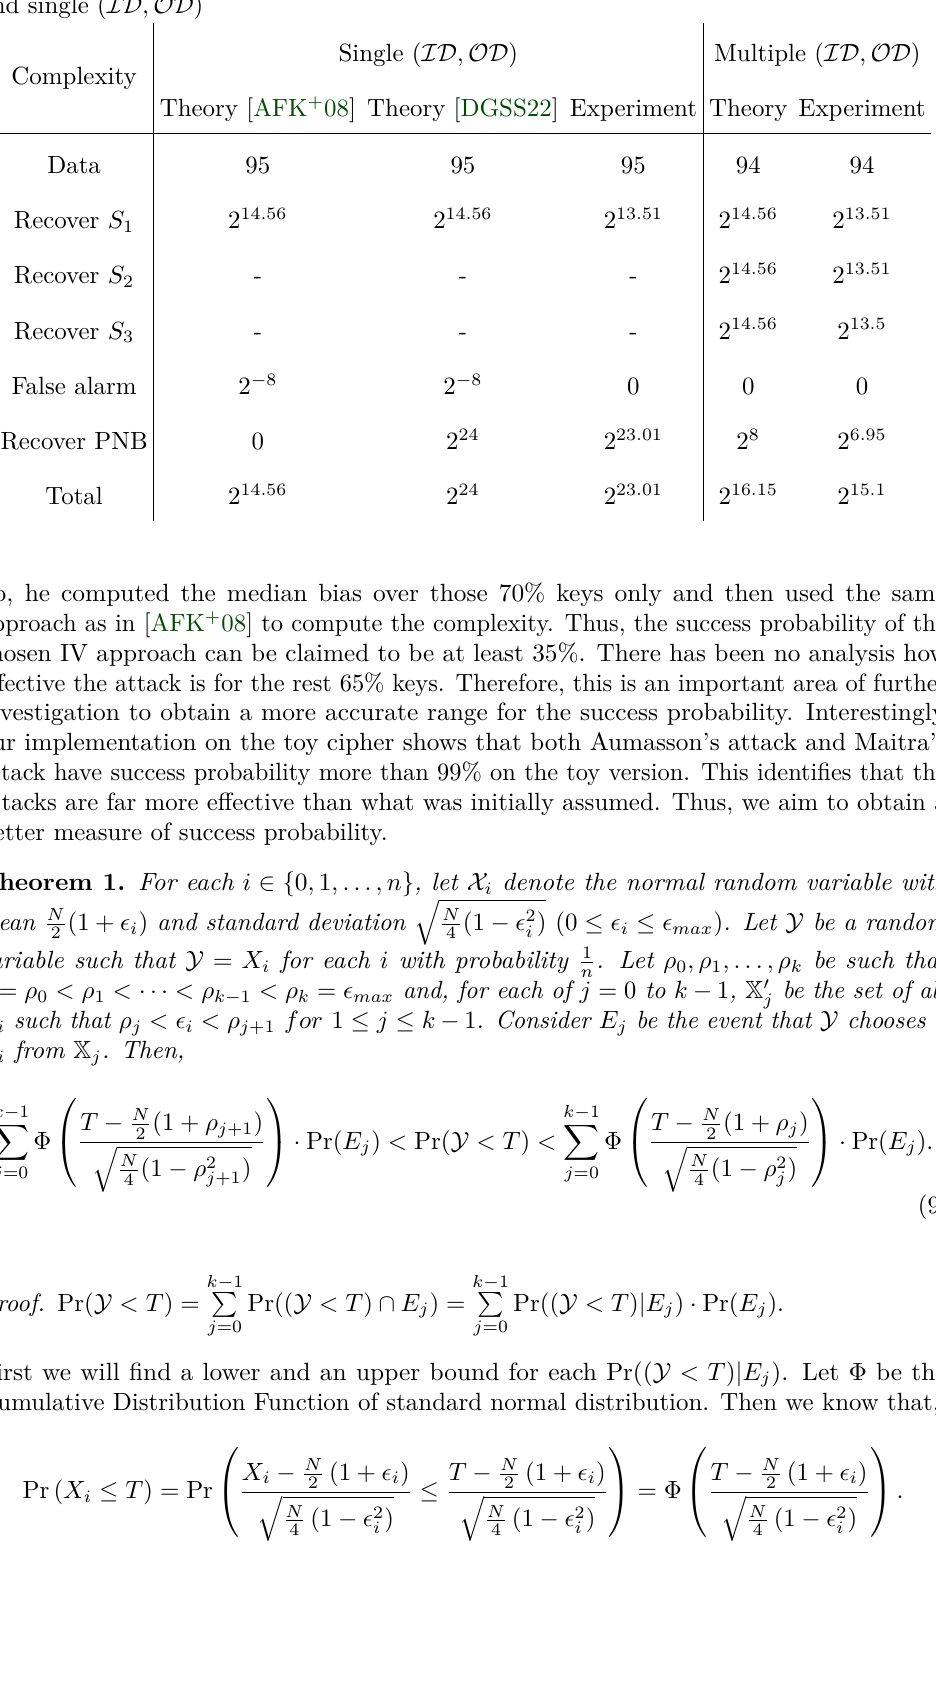
Table 4: Comparison of theory and experiments for 3-round attack using multiple ( ID , OD ) and single ( ID , OD